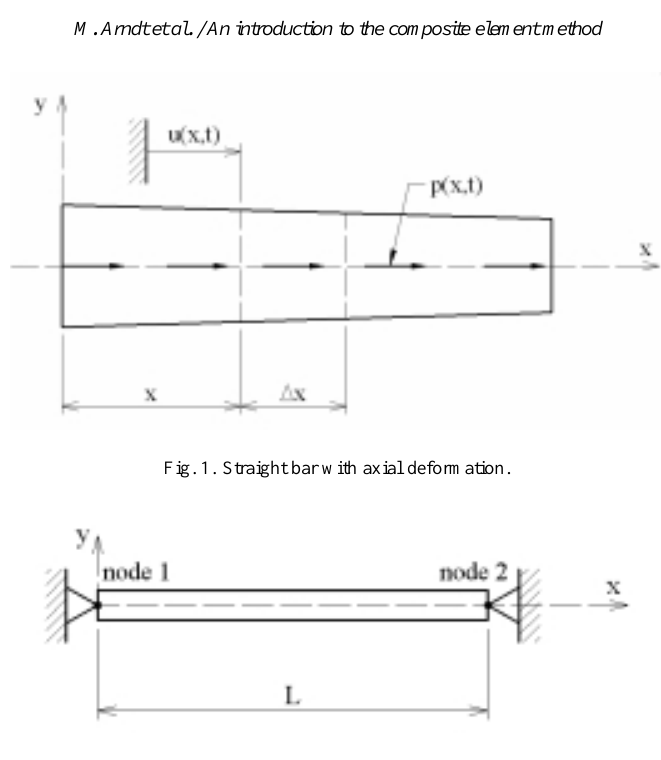
Fig. 2. Boundary conditions of the bar for interpolation functions of the